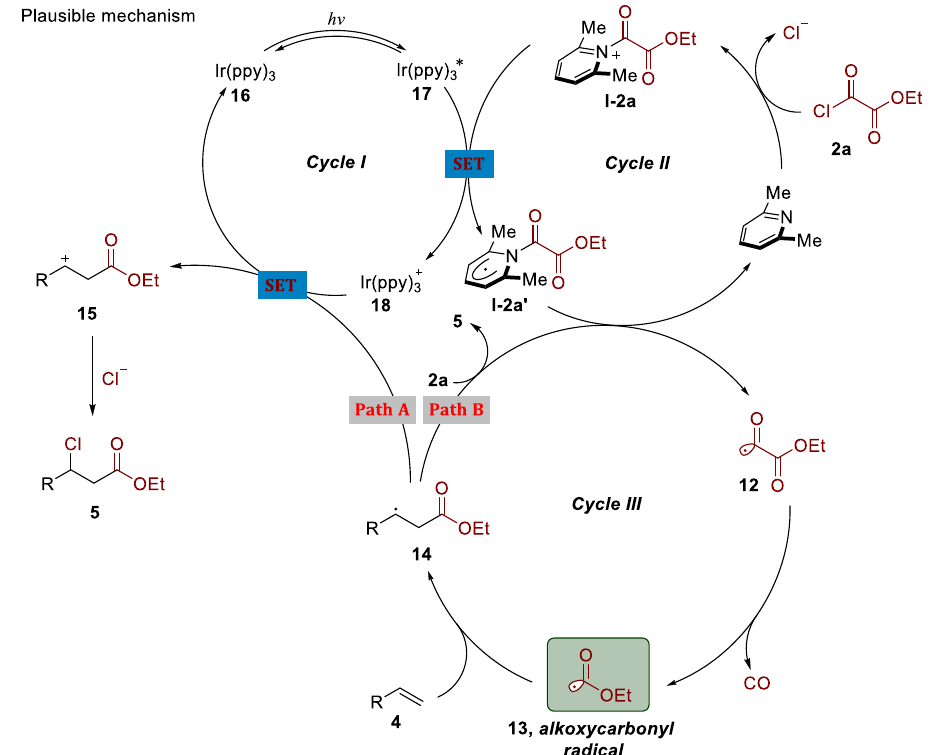
Fig. 9 Plausible mechanism for photocatalyzed alkoxycarbonylchlorination. Cycle I: photocatalytic cycle. Cycle II: 2,6-lutidine-initiated catalytic cycle with compound 2a . Cycle III: chain pathway for the generation of alkoxycarbonyl radical 13 via